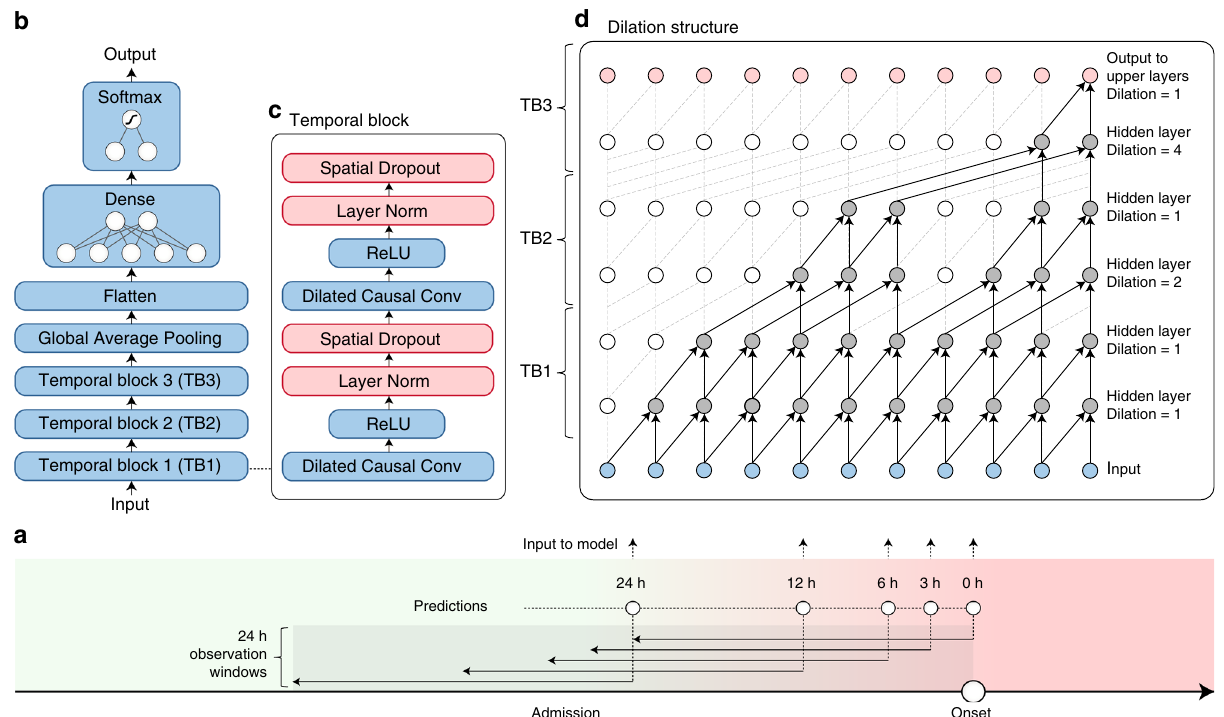
Fig. 6 The xAI-EWS model architecture. The models in this study are trained and evaluated at 0, 3, 6, 12, and 24 h before the onset of critical illness. Each model has a 24-h retrospective observation window. The color gradient from green to red illustrates continuous deterioration towards acute critical illness ( a ). The overall model architecture of the AI-EWS model is shown in b . The xAI-EWS uses three temporal blocks ( c ), each comprising one-dimensional dilated causal convolution layers, ReLU activations, one-dimensional dropout layers, and normalization layers. Red layers are only used during training and are omitted when the model is used for predictions and explanations. The overall dilation structure of the model is shown in d . The one-dimensional dilated causal convolution layers allow the model to skip some points during convolution and, thereby, increase the receptive fi eld of the model. The dilation structure is illustrated for kernel size = 2.